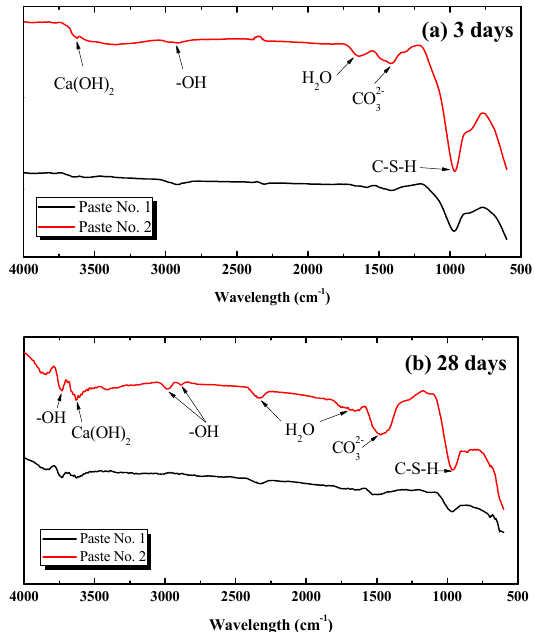
Figure 6. Fourier transform infrared spectroscopy (FT-IR) spectrum of tested pastes at different ages. Variation of wavelength at ( a ) 3 days of curing and ( b ) 28 days of curing.